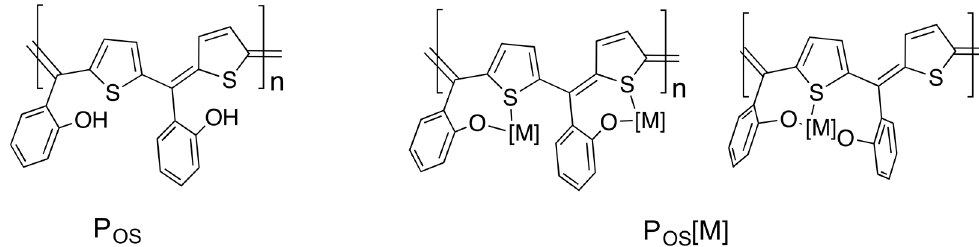
Figure 1. Chemical structures of the poly(heteroarylene) methine polymer P OS and its metal complex P OS [M], where the indices OS represent bi- or tridentate coordinating modes and [M] is a metal center with any co-ligands.